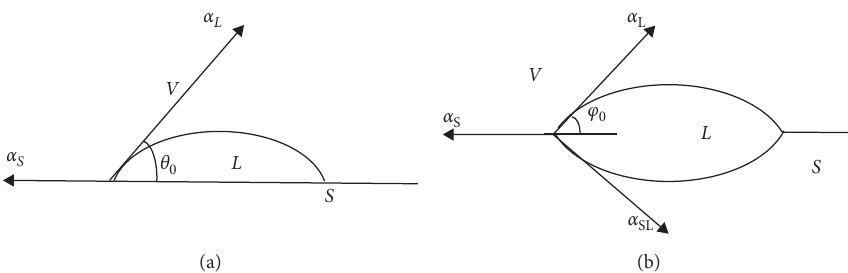
Figure 2: Scheme of the three phases in the conjugation: solid, liquid, and vapor: (a) at a thermodynamic position of nonequilibrium but with mechanical equilibrium of the droplet on the crystal surface and (b) at a position of thermodynamic equilibrium of the catalyst droplet on the crystal